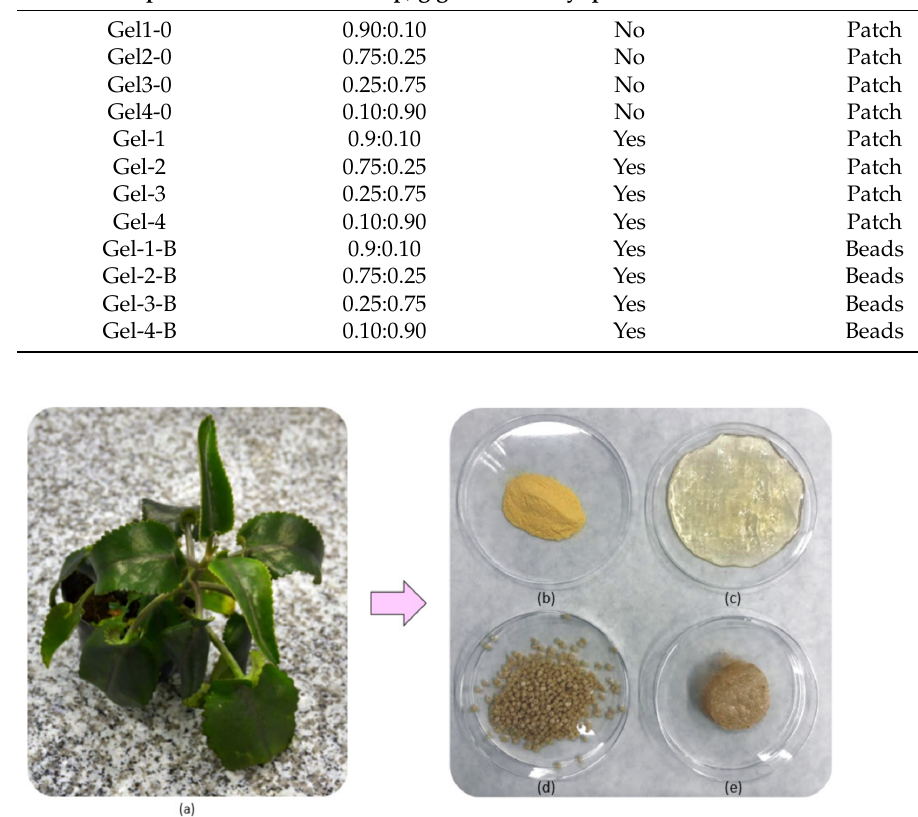
Figure 1. Photographs of ( a ) Kalanchoe pinnata plant used for extracts preparation ( b ) native chitosan (CS) ( c ) crosslinked hydrogel; ( d ) ready hemostatic agent in the form of beads; ( e ) hemostatic agent in the form of a